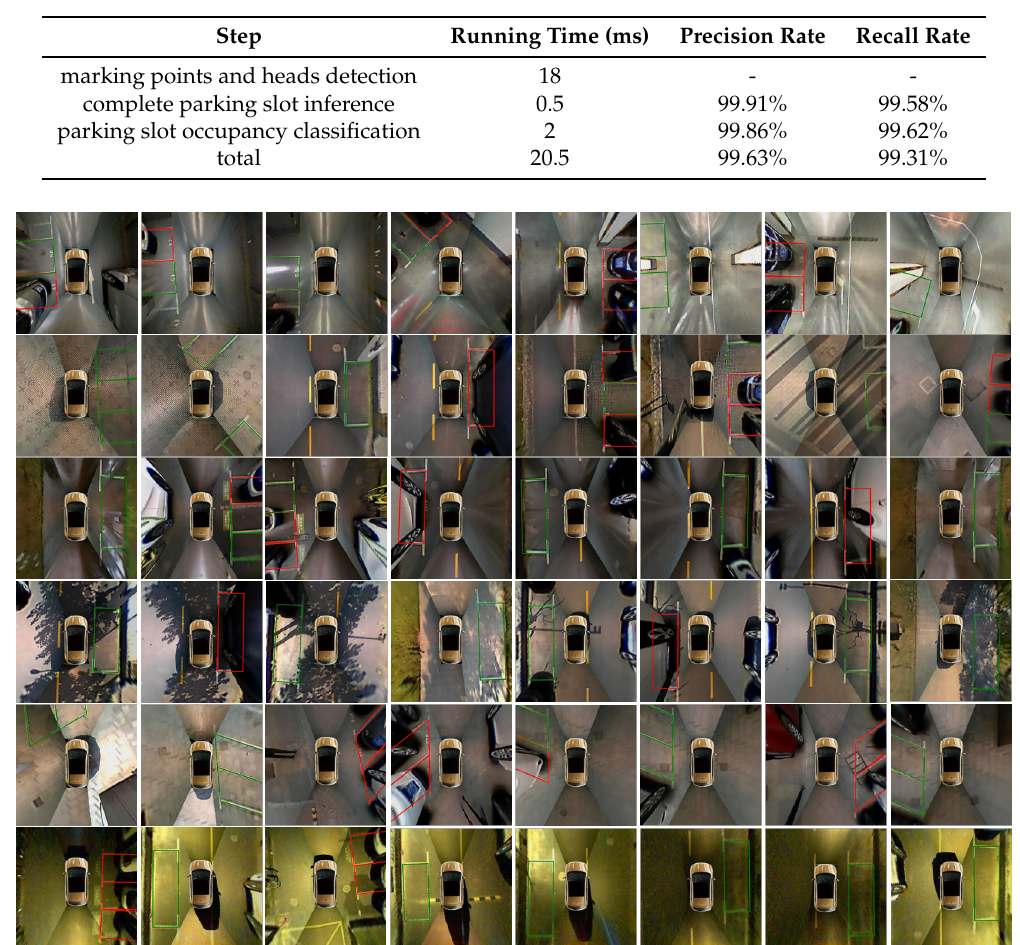
Figure 15. VPS-Net detection results. Green indicates the vacant parking slot. Red indicates the non-vacant parking slot. Different rows show three kinds of parking slots in various imaging conditions like ’indoor’, ’outdoor daylight’, ’outdoor rainy’, ’outdoor shadow’, ’outdoor slanted’, ’outdoor street light’